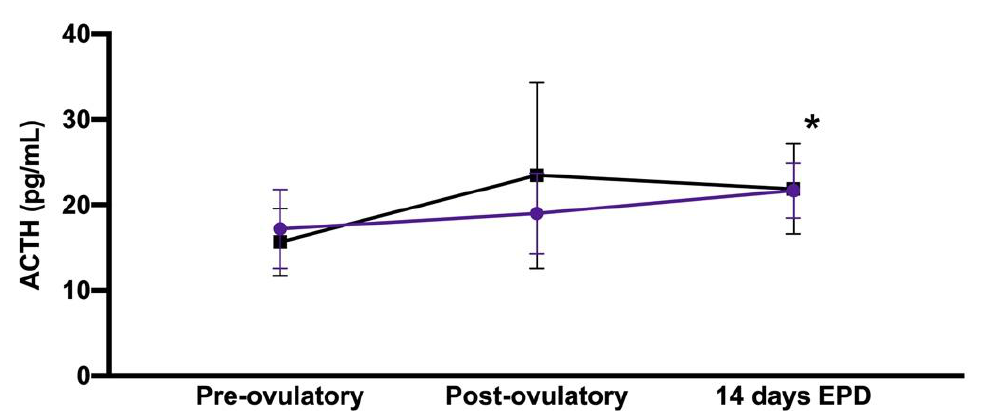
Figure 2. Mean ± standard deviation for immunoreactive plasma ACTH concentrations associated with age and peri-ovulatory period, showing a significant effect of time in the peri-ovulatory period ( p = 0.04). Purple discs indicate mares ≥ 12 years of age (n = 6), and black squares indicate mares < 12 years of age (n = 12). * p < 0.05 14-day EPD vs. pre-ovulatory, regardless of the age of the mare. The x-axis does not reflect the time scale.